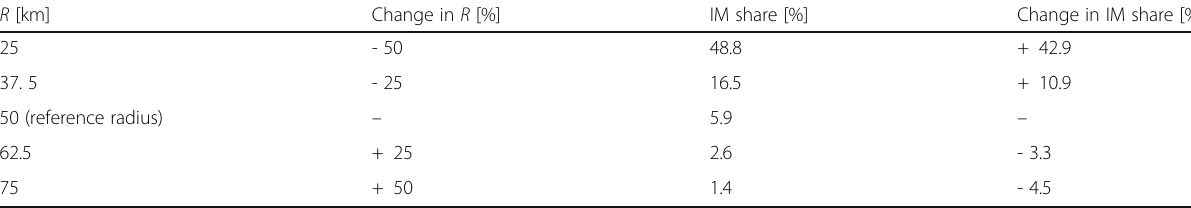
Table 2 Sensitivity analysis of intermodal share with regard to the radius of the market area ( s = 400